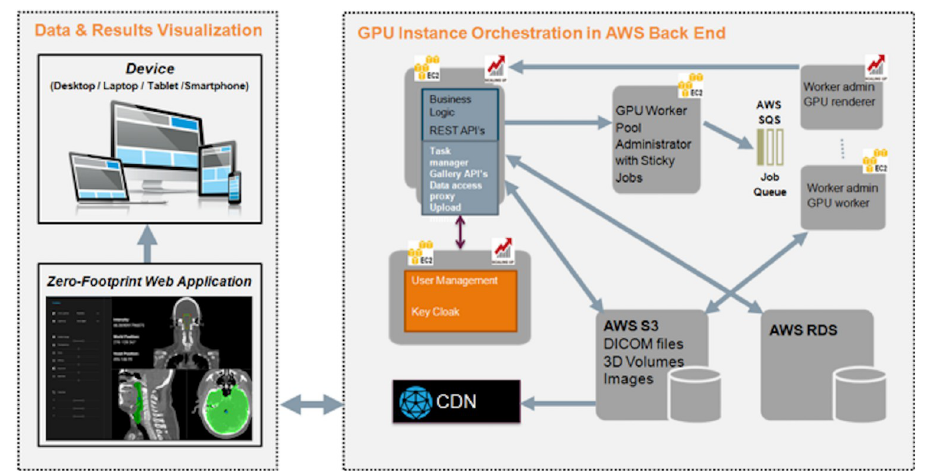
Fig 6. Graphic processing unit instance orchestration on the